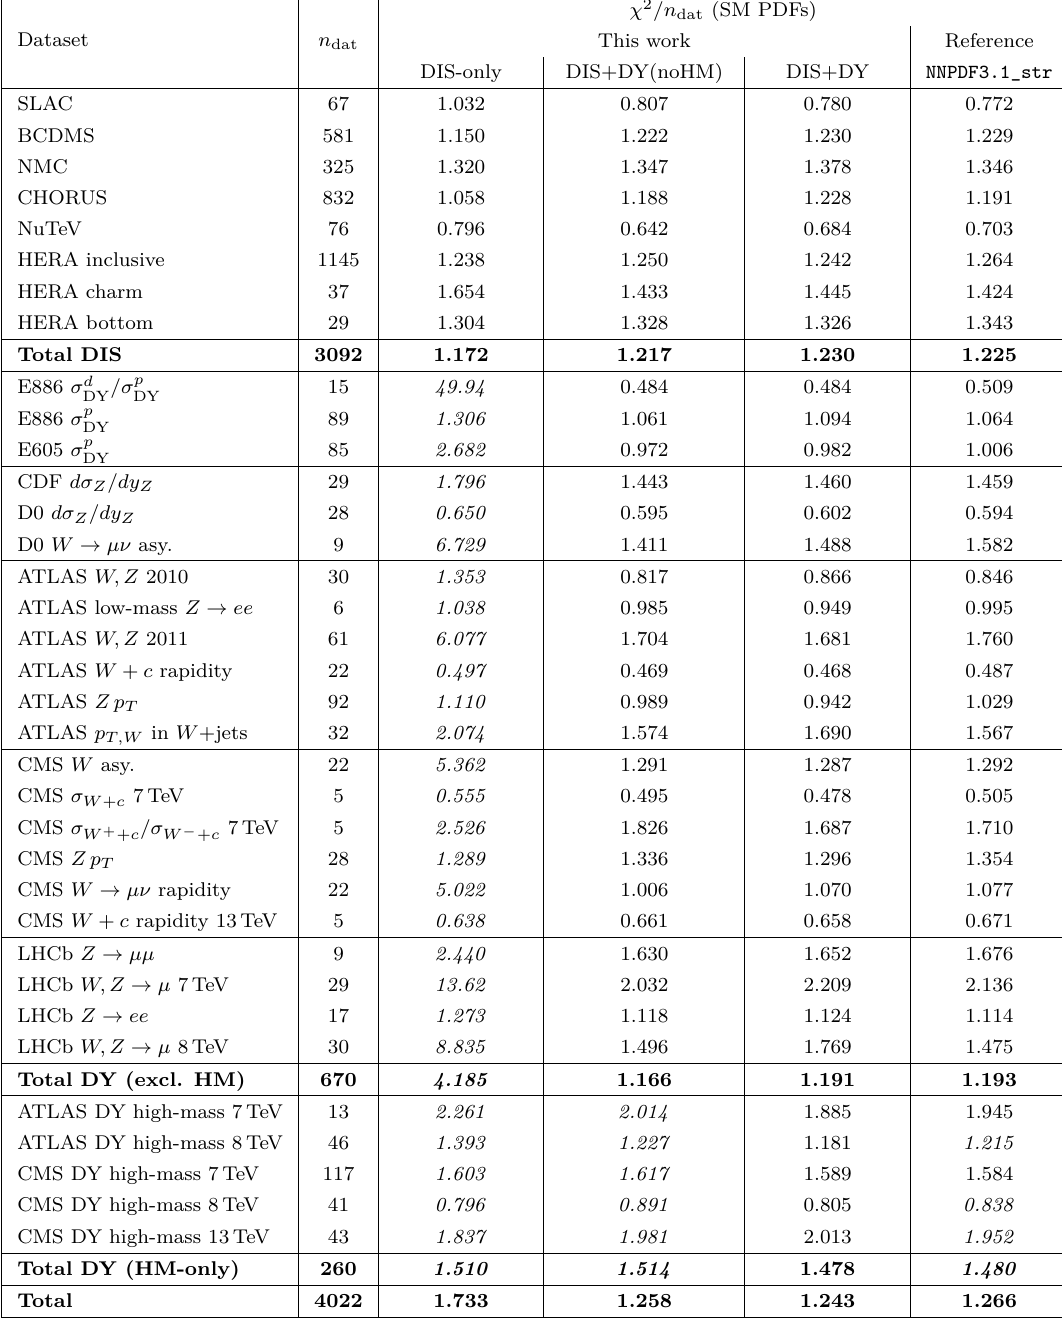
Table 10 . The values of the χ 2 per data point for the baseline SM PDF fit, labelled “DIS+DY”, and for the corresponding fits based on reduced datasets. Here eq. (3.5) is evaluated using the t 0 prescription. We also include the results obtained using NNPDF3.1_str with the kinematic cuts used in this work and summarised in table 9. Values in italics indicate datasets that do not enter the corresponding